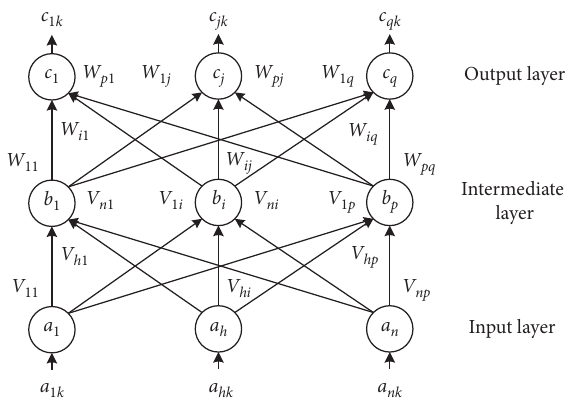
Figure 3: Structure of BP network model. Table 2: Experimental data of